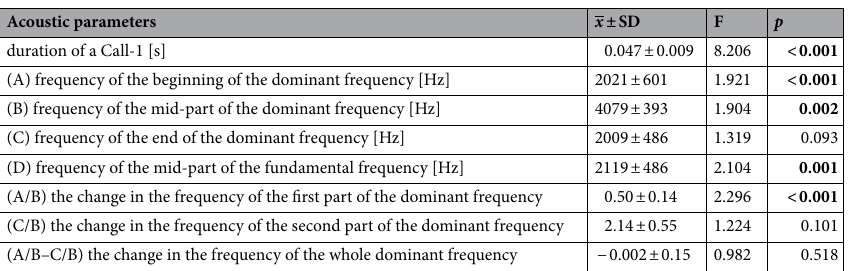
Table 1. ANOVA test for the between-individual differences in eight parameters of Call-1, n = 31 individuals, 310 calls.